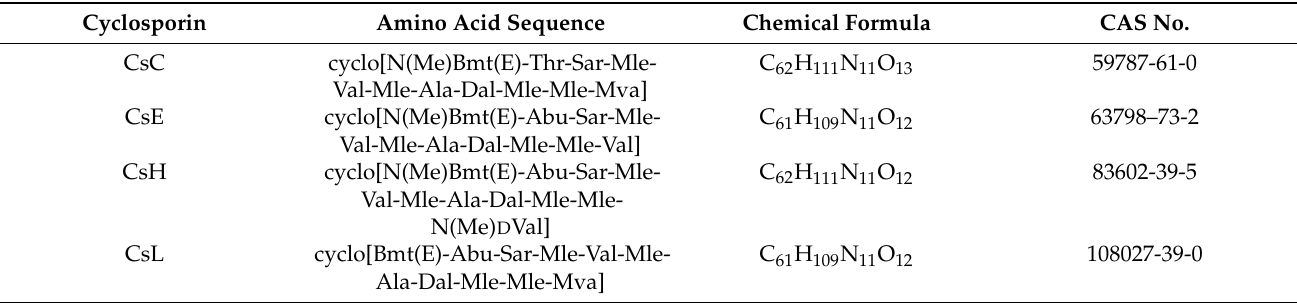
Table 1. Composition of cyclosporins. Short names for N-methylated amino acids: Mle for N(Me)Leu and Mva for N(Me)Val. Dal is D